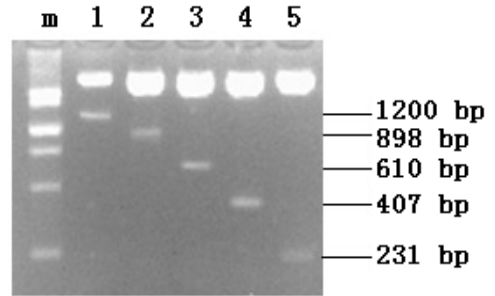
Figure 2. Identification of the recombinant plasmids by double enzyme digestion. m : DNA marker; 1 , 2 , 3 , 4 , and 5 denote the double enzyme digestion of pGL3-1200, pGL3-898, pGL3-610, pGL3-407, and pGL3-231,